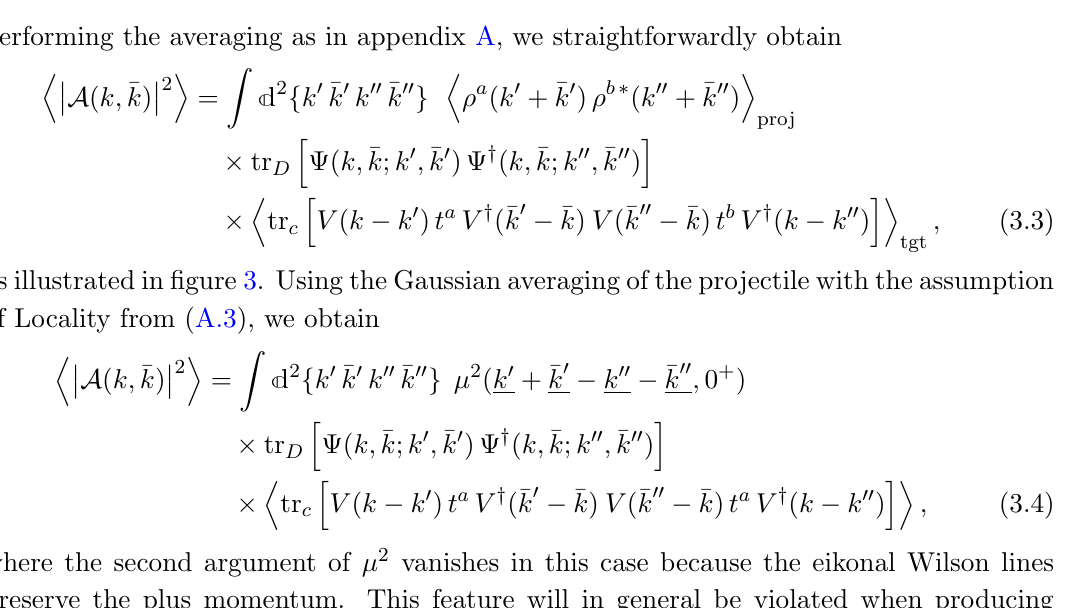
Figure 3 . The cross section for producing a q (cid:22) q pair as written in eq. (3.3). The vertical dotted lines denote the e(cid:11)ective positions of the Wilson lines, which shift the quark and antiquark momenta from k; (cid:22) k in the (cid:12)nal state to k 0 ; (cid:22) k 0 in the amplitude and k 00 ; (cid:22) k 00 in the complex-conjugate amplitude. Note that the form of the amplitude (2.7) makes it possible to write all time orderings as if the q (cid:22) q pair passed through the shockwave as illustrated